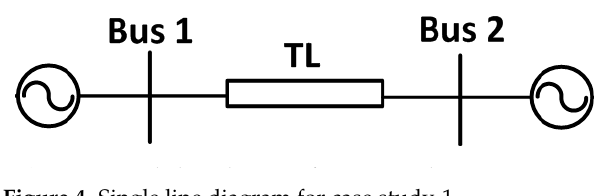
Figure 4. Single line diagram for case study-1. Table 2. Actual and estimated parameters using four quarters of the measured